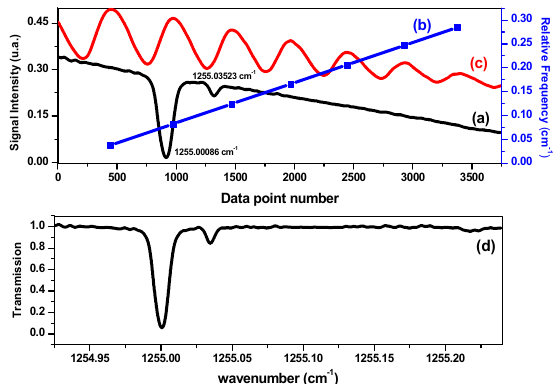
Figure 3. Absorption signal of 3000 ppm CH 4 at 4.62 mbar ( a ); converted into an absorption spectrum ( d ) using the relative frequency calibration curve ( b ) which allows one to convert “data point number” into “wavenumber” by means of the interference fringes resulting from a Fabry ‐ Perot interferometer with a FSR of ~0.033 cm − 1 ( c ).